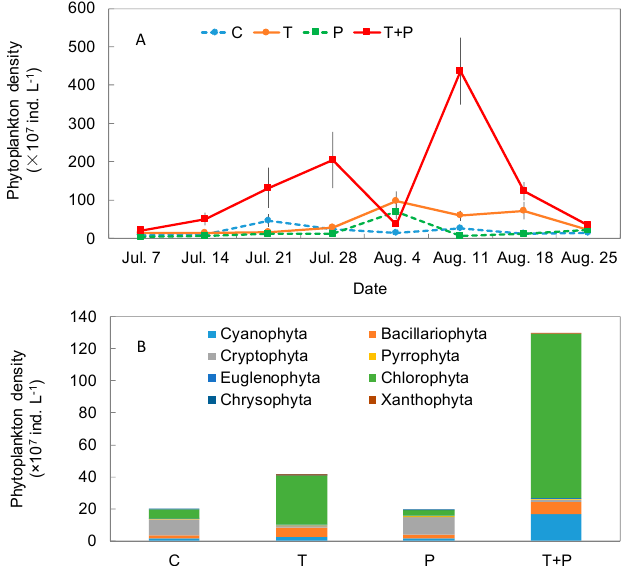
Figure 2. Total phytoplankton density ( A ) and phytoplankton community structure ( B ) variation in the C, T, P, and T + P treatments during the summer in the mesocosms. Abbreviations used: Control, C; water temperature was increased 4.5 ◦ C compared with the control, T; addition of 50 µ g L − 1 phosphate every 2 weeks, P; addition of 50 µ g L − 1 phosphate every 2 weeks and temperature increase of 4.5 ◦ C, T + P. Error bars indicate ± standard error